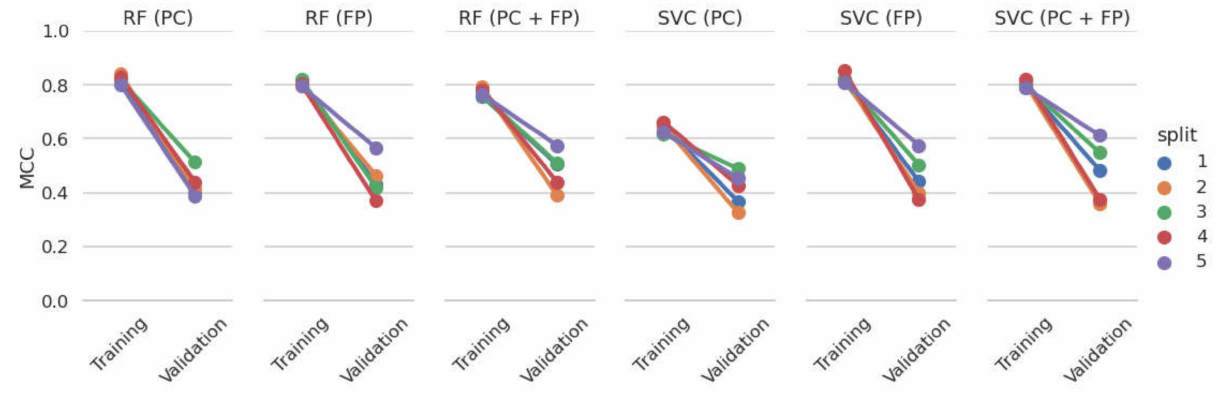
Figure 3. The MCC on the training and validation set of each ML model (denoted by the sub chart titles) and cross-validation split (indicated by